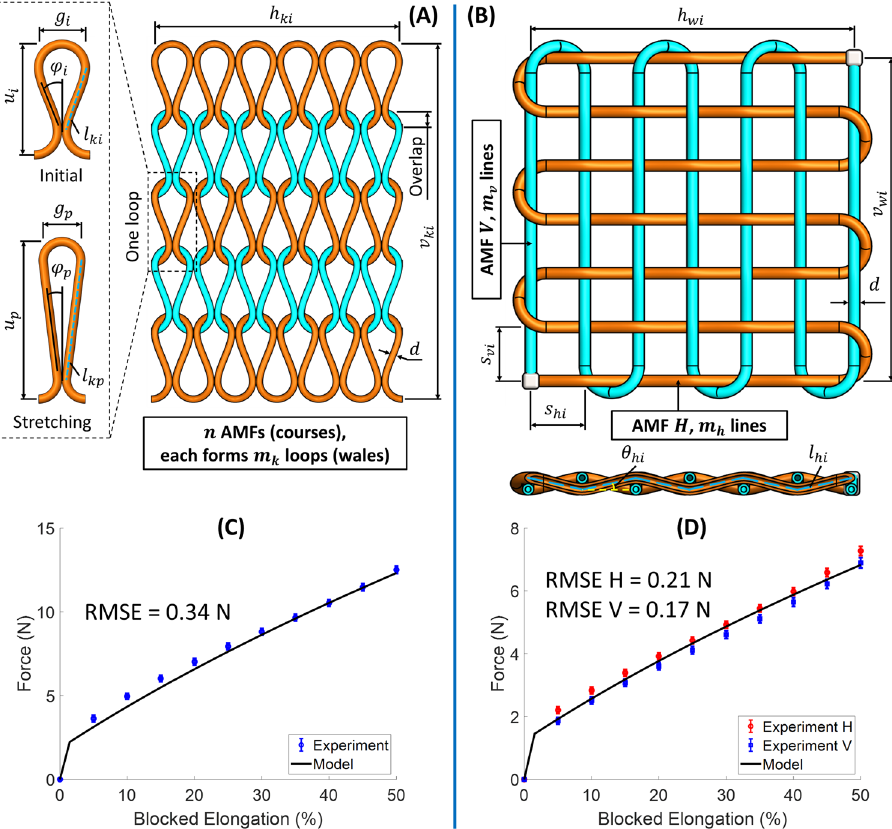
Figure 5. Analytical models to establish the elongation-force relationship. ( A , B ) Analytical model illustration for knitting and weaving sheets, respectively. ( C , D ) Comparison between analytical models and experimental data for knitting and weaving sheets, respectively. RMSE root mean square